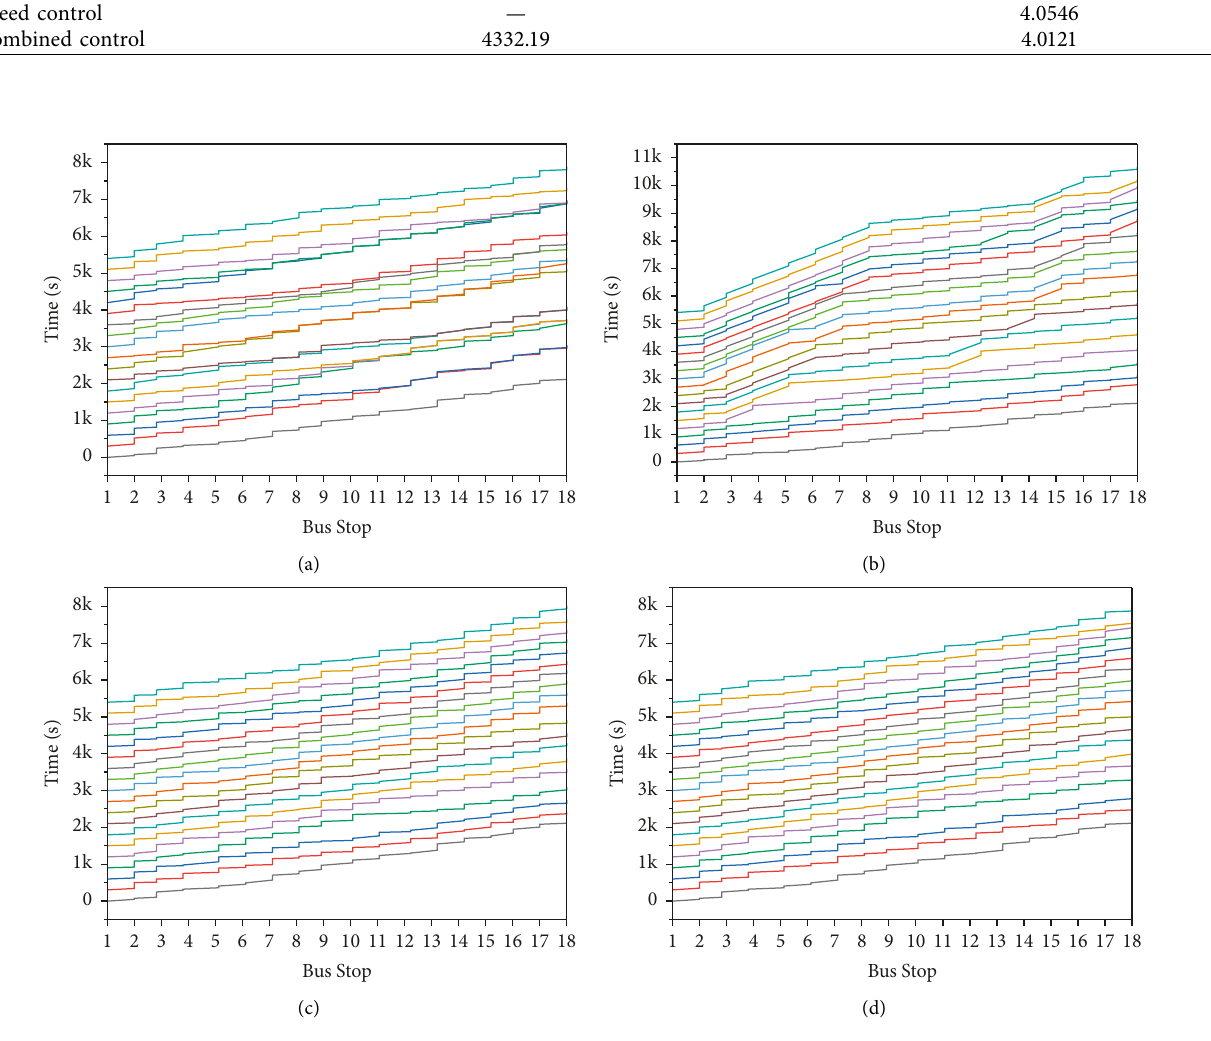
Figure 13: Bus trajectories. (a) NC. (b) ep �− 80%. (c) ep � 0. (d) ep �